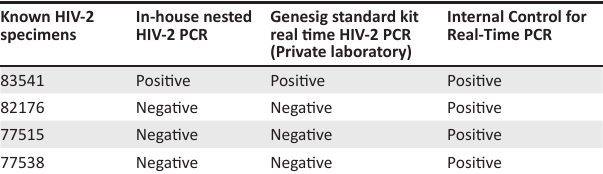
TABLE 2: HIV-2 polymerase chain reaction results of the four known HIV-2 antibody positive specimens. Known HIV-2 In-house nested specimens HIV-2 PCR